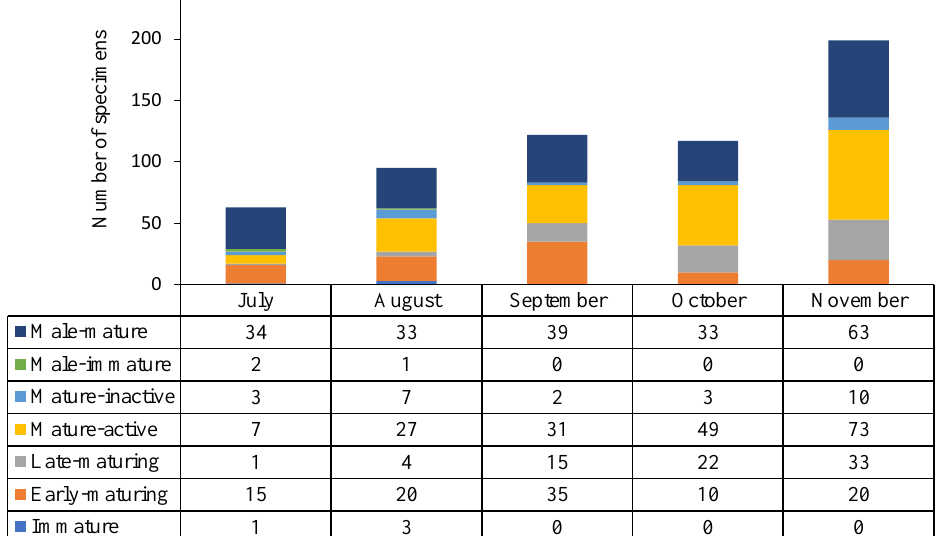
Figure 4. Monthly number of wahoo specimens grouped per maturity stages (two for male specimens: first two rows; five for females: last five rows) in the Western and Central Pacific Ocean. Numbers in the table represent monthly catches per maturity stage.